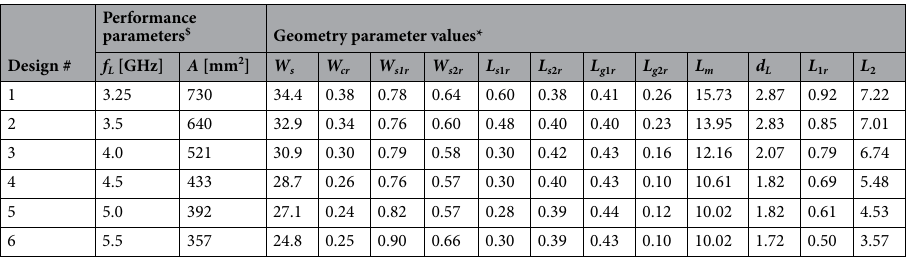
Performance parameters $ Geometry parameter Design #